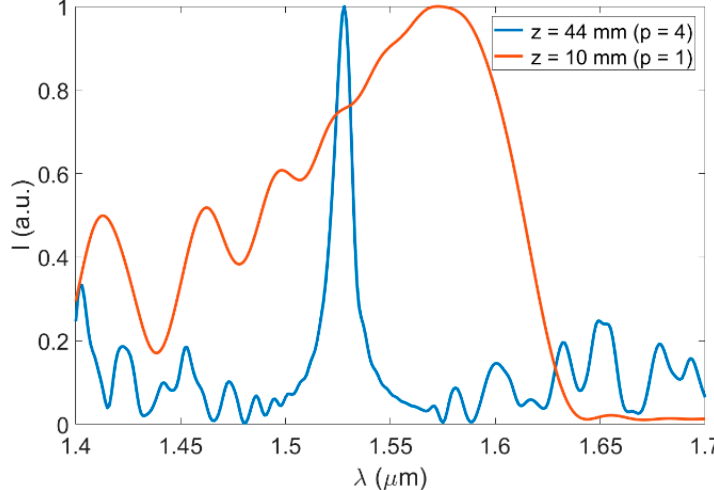
Figure 4. Normalized spectral response of an SMF-MMF with SMF/MMF with core diameters of a = 8.6/105 µ m and numerical apertures NA = 0.12/0.22, respectively. The two curves show the output intensity at different propagation distances z, as indicated, which correspond to the first image ( p = 1) and fourth image ( p = 4) of the MMI structure.